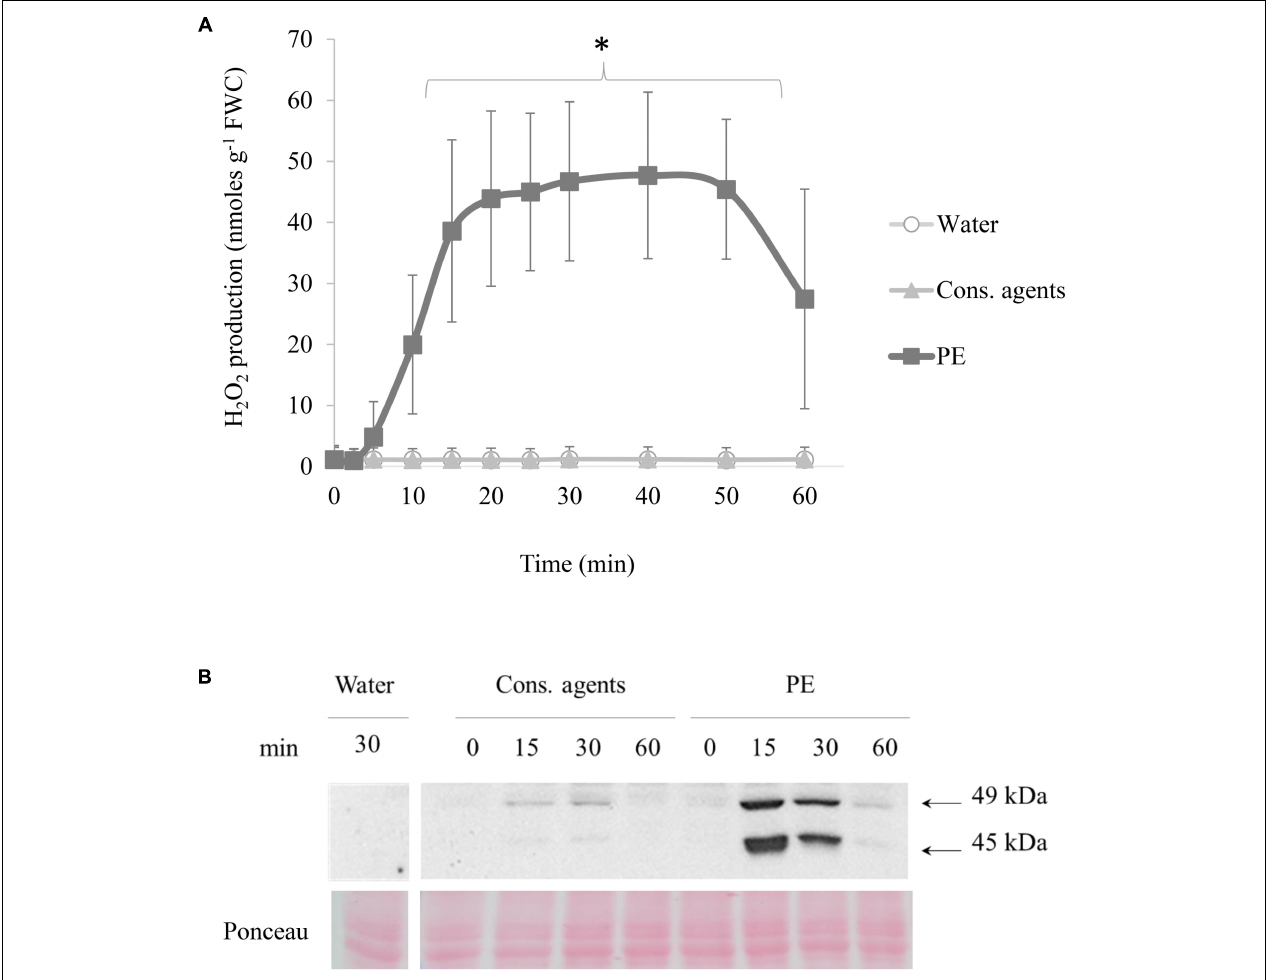
FIGURE 2 | Effects of PE on early signaling events in cell suspensions. Grapevine cell suspensions, adjusted to 0.1 g of fresh weight cell (FWC) mL − 1 , were treated with PE (0.5 g L − 1 ), or equal volumes of cons. agents or water. (A) H 2 O 2 production in cell suspension, measured by luminol chemiluminescence method. Data were converted from Relative Luminescence Unit (RLU) to nmoles H 2 O 2 g − 1 FWC according to a calibration curve of H 2 O 2 concentration range. Results correspond to the mean ± confidence interval of three independent biological repetitions. Significant differences were identified with Student t -test comparison